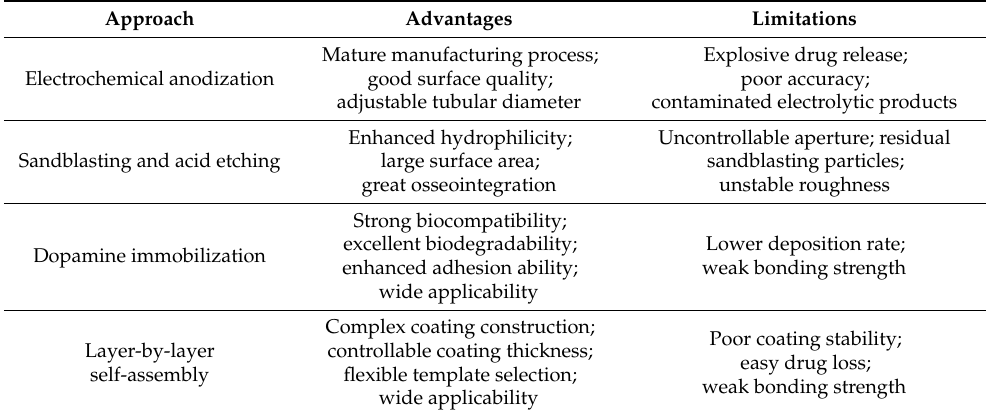
Table 1. General approaches for constructing drug delivery systems using Ti-based